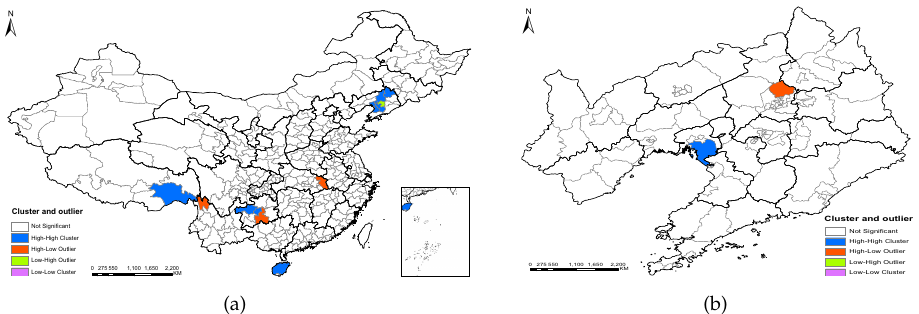
Figure 4. From 1 August 2018 to 31 August 2019: ( a ) Local indicators of spatial association (LISA) maps for the incidence of ASF at the city level in Mainland China. ( b ) Local indicators of spatial association (LISA) maps at the district or county level in Liaoning